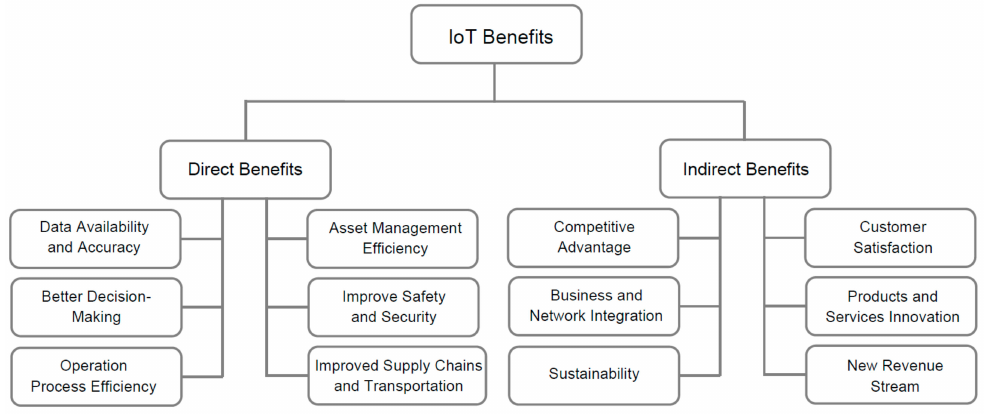
Figure 7. IoT benefits for